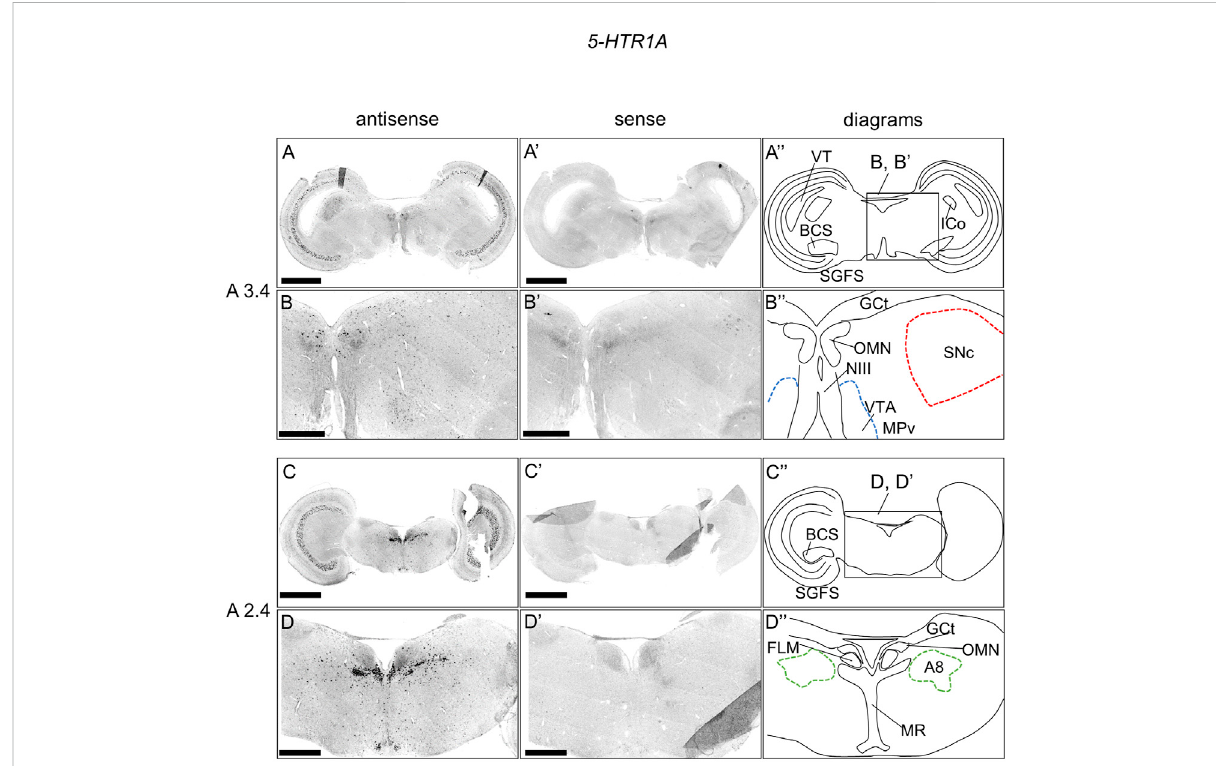
FIGURE 2 In situ hybridization of 5-HTR1A in the P1 chick brainstem. Digoxigenin-labeled RNA antisense (A – D) and sense (A 9 – D 9 ) 5-HTR1A probes were used for in situ hybridization in coronal sections of P1 chick brainstems. To evaluate the expression patterns of 5-HTR1A , we analyzed sections from fi vechick brainstems;representativeimagesofchick brainstemsectionsareshown. (B) and (B 9 ) and (D) and (D 9 ) Magni fi edviewsofbrainareasinthe boxin (A 99 ) and (C 99 ) . (A 99 – D 99 ) Diagramsofcoronalsectionsshownintherightmostpanels.Thelevelsofexpressioninsections(A3.4andA2.4) were in accordance with those mentioned in the Kuenzel and Masson ’ s chick atlas (Kuenzel and Masson, 1988). A8: A8 cell group; BCS, brachium colliculi superiors; FLM, fasciculus longitudinalis medialis; GCt, griseum centrale; ICo, nucleus intercolicularis; MR, median raphe; NIII, nervus oculomotorius; OMN, oculomotor nucleus; P1, post-hatch day 1; PPT, pedunculopontine tegmental nucleus; SGFS, stratum griseum et fi brosum super fi ciale; SNc, substantia nigra pars compacta; VT, ventriculus tecti mesencephalic; VTA, ventral tegmental area. Scale bars = 2.5 mm (A,C) and (A 9 ,C 9 ) and 1 mm (B,D) and (B 9 ,D 9 )